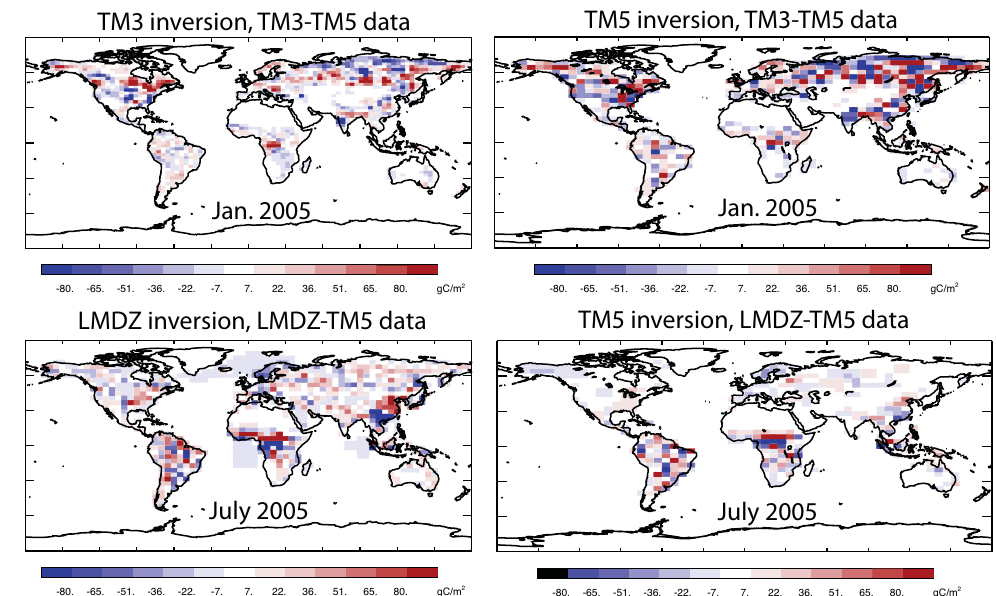
Fig. 7. Examples fluxes derived from different inversion using the same samples. Top panels: TM5 and TM3 inversion using the difference between TM5 and TM3 derived A-SCOPE samples for January. Bottom panels: TM5 and LMDZ inversion using the difference between TM5 and LMDZ derived A-SCOPE samples for July.